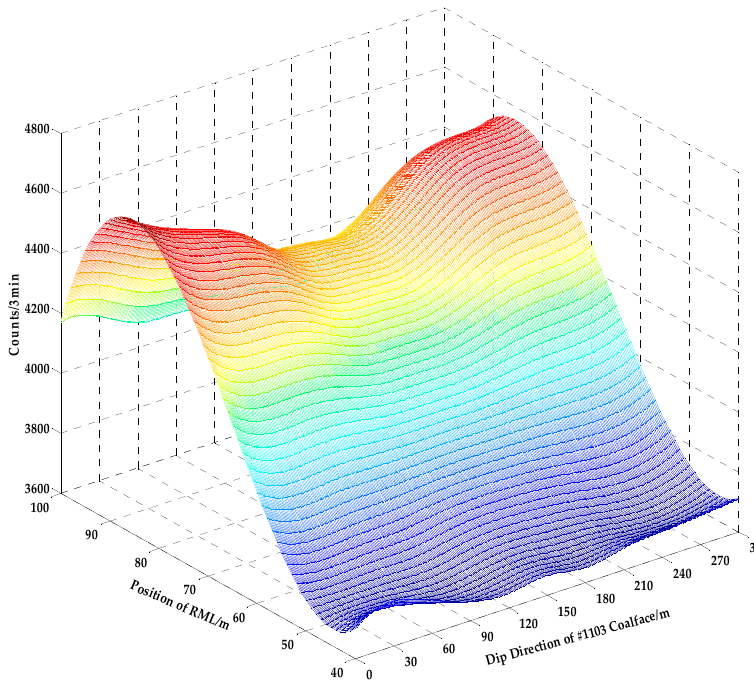
Figure 11. Radon counts from the RMPs.